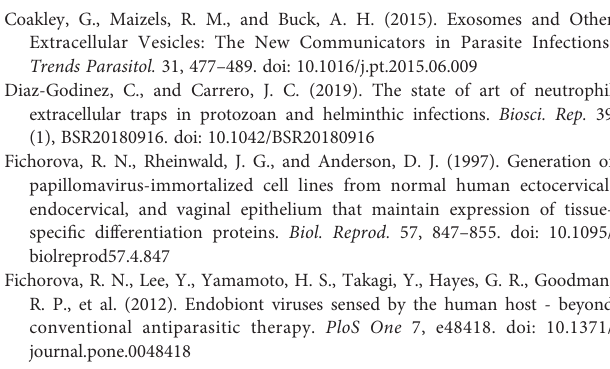
SUPPLEMENTARY TABLE 1 | Proteomics data analysis. Data analysis sheets contain (i) the protein list of TV phenotype 1 (virus-negative) vs. phenotype 2 (virus- positive) with statistical analyses and includes UniProt accession number, gene symbol, log2 fold change (FC), FC, p-values and identi fi cation of common contaminants and (ii) the gene ontology (GO) analysis for protein class and molecular function using PANTHER classi fi cation system